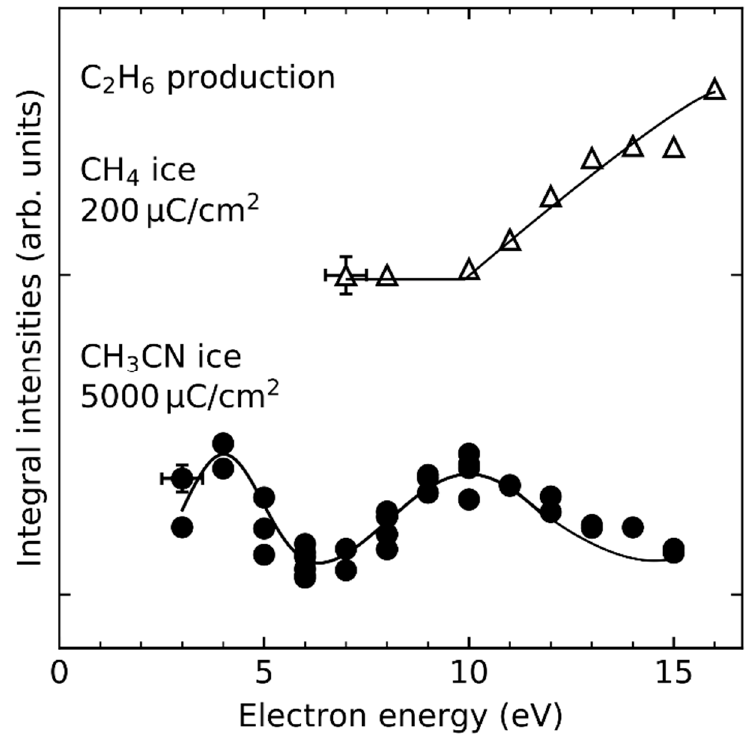
Figure 7. Energy dependence of the integrated desorption signals of ethane C 2 H 6 from the recombi-nation of methyl radicals formed during electron irradiation of CH 4 (this work) or CH 3 CN [25]. Error bars in the upper series were estimated to be 10% of most intense peak. The solid lines serve as a guide to the eye. Adapted from Ref. [25] with kind permission of The European Physical Journal (EPJ).